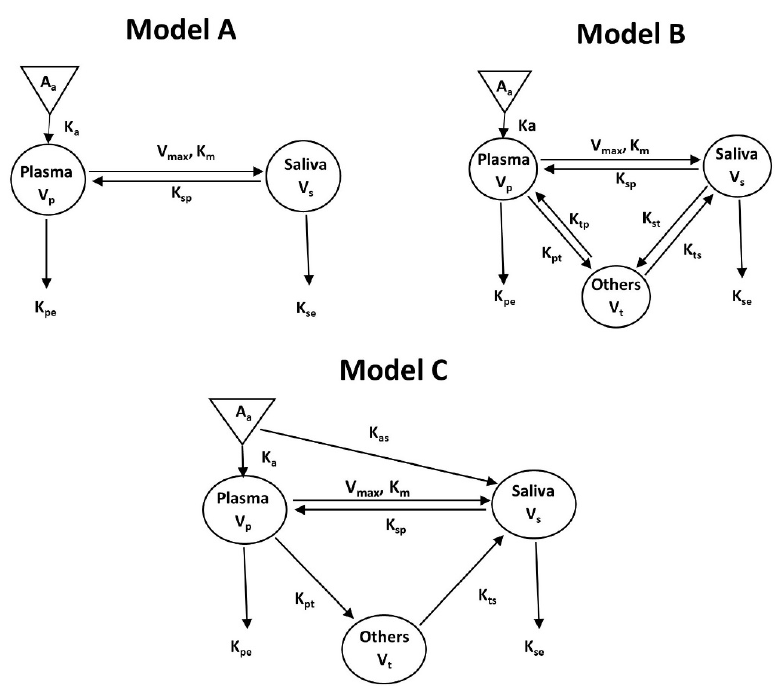
Figure 4. Proposed model structures for Matr in human plasma and saliva. The parameters in models